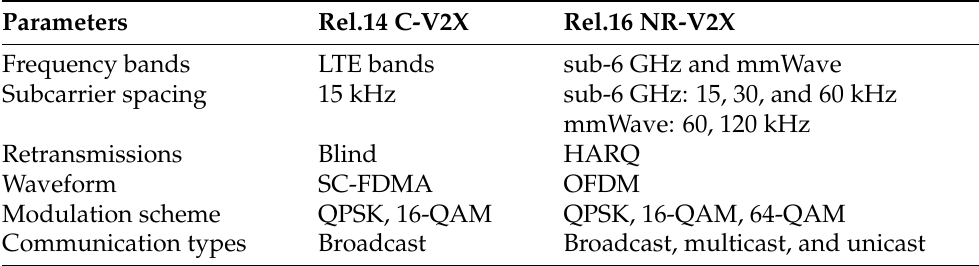
Table 4. Comparison between specifications of LTE C-V2X and 5G NR-V2X [56].